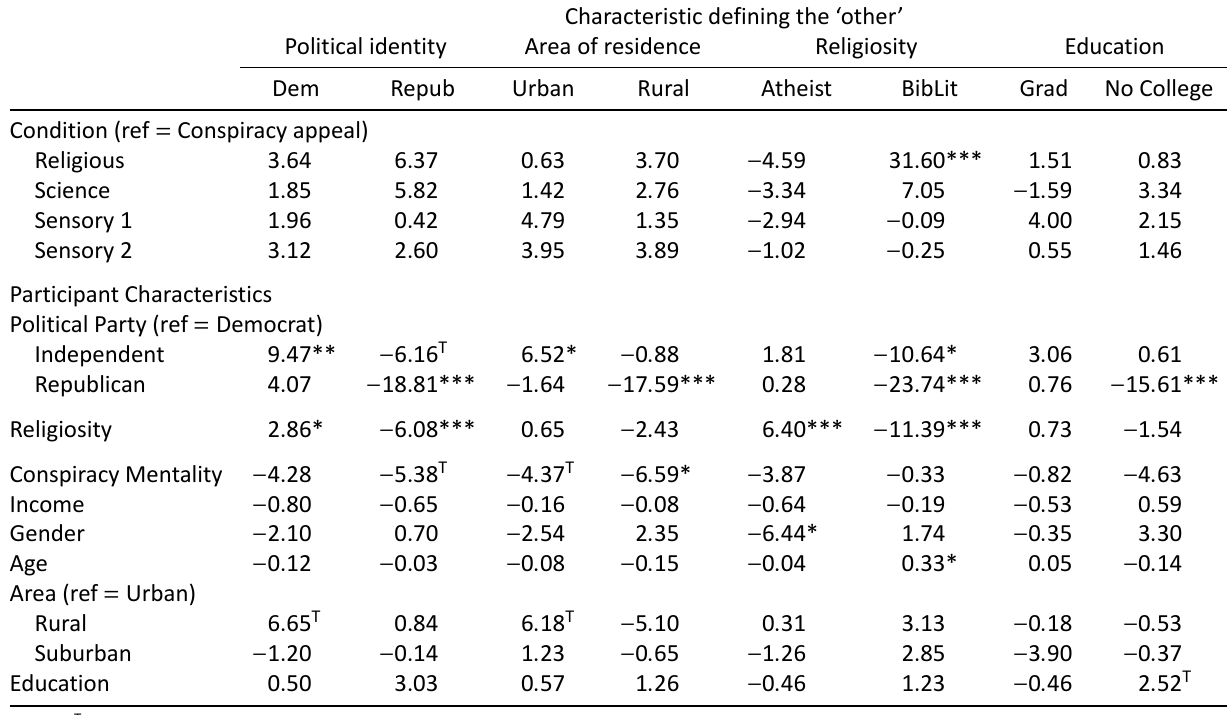
Table 2. GLM analyses for each identity group. Non-standardized regression coefficients are shown.